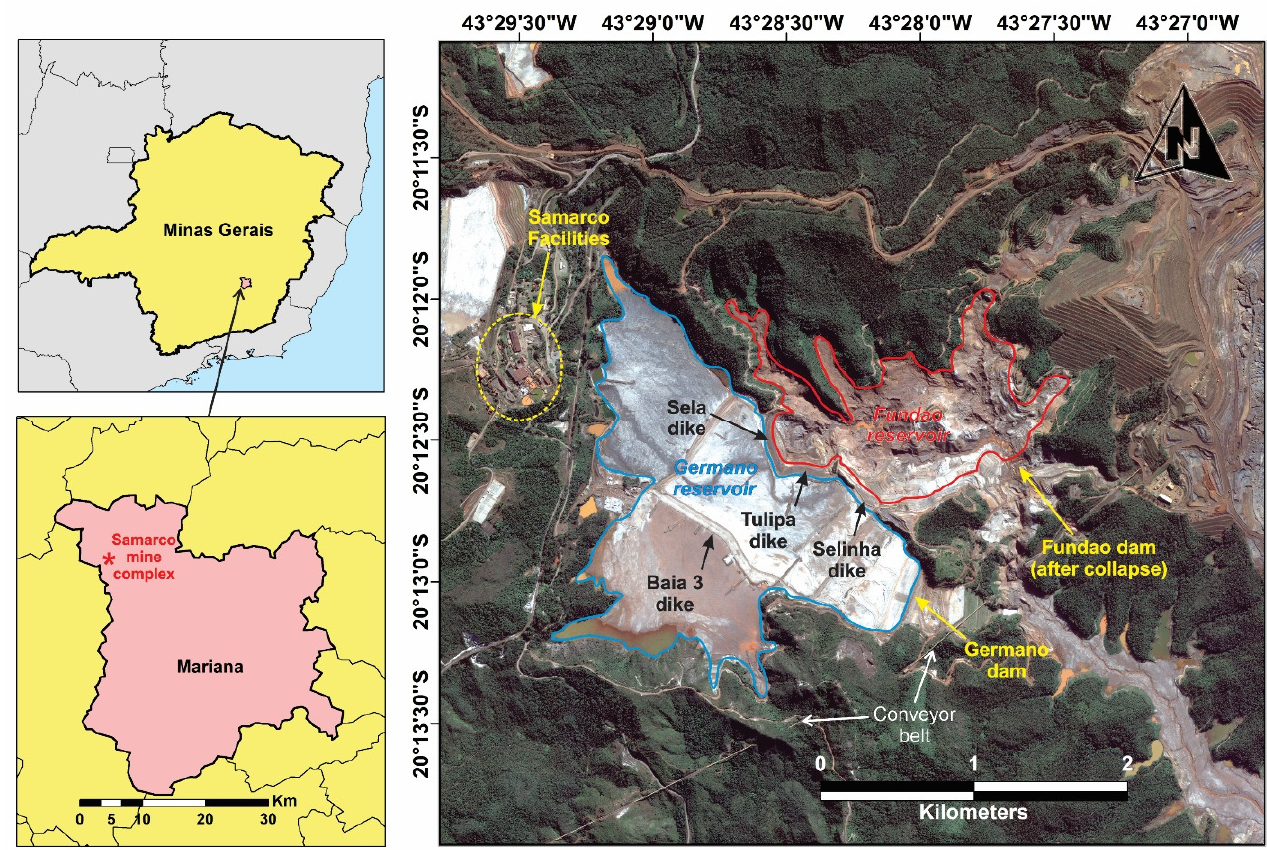
Figure 1. Germano iron complex location in Mariana/MG; the background image was obtained from Google Earth.